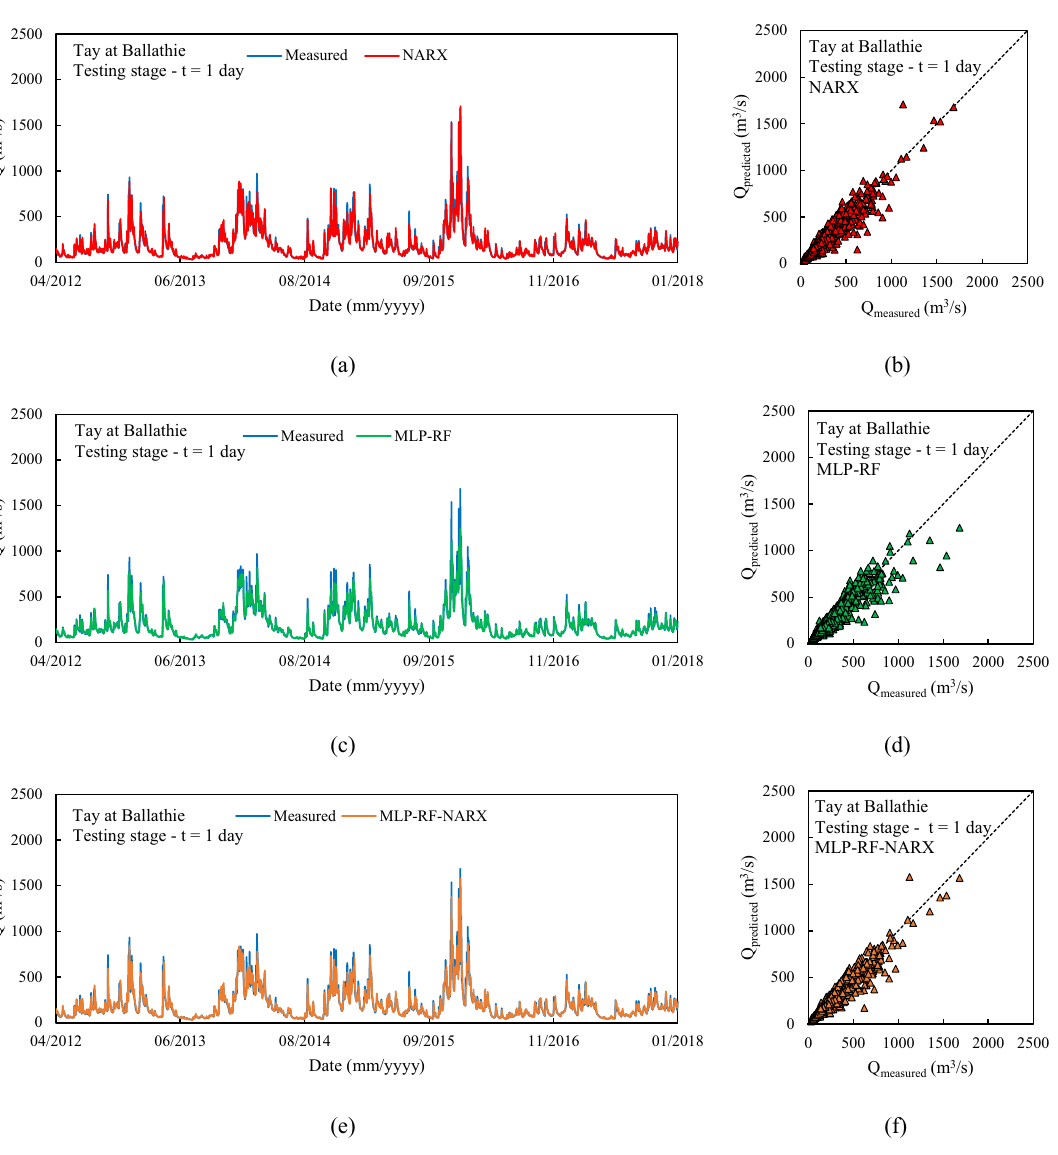
Figure 6. 1-day ahead predictions for Tay at Ballathie: NARX ( a , b ); MLP-RF ( c , d ); MLP-RF-NARX ( e , f